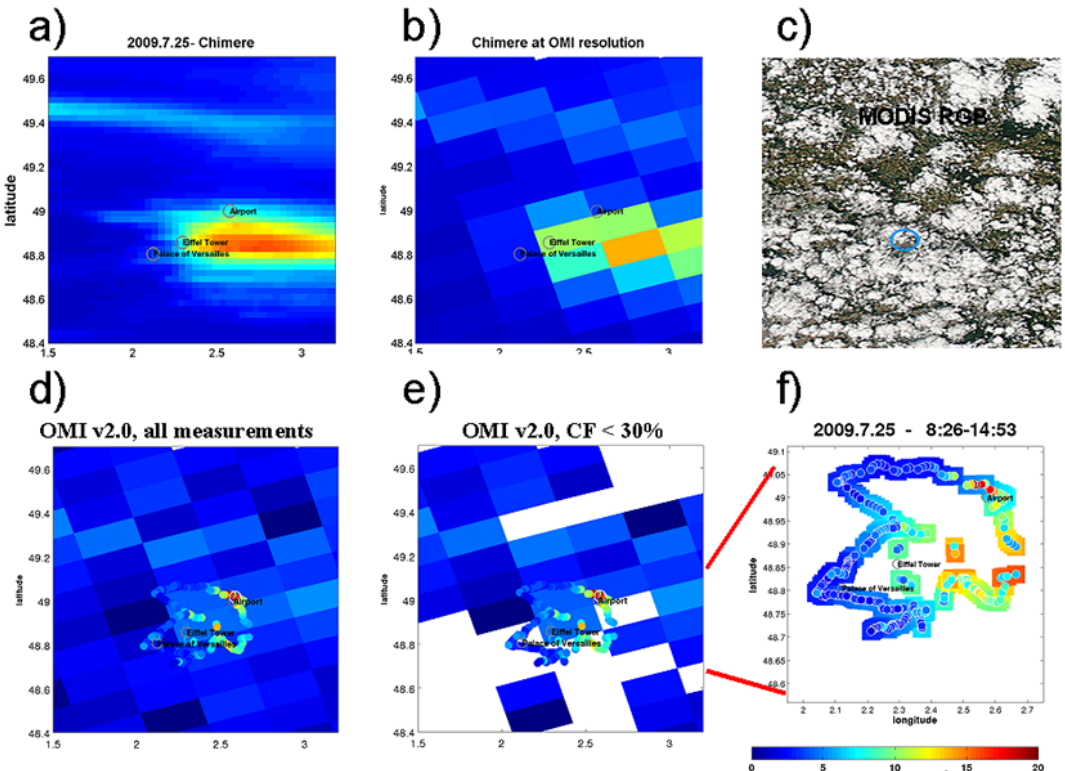
Figure 4. Same as Fig. 3 for the 25 July 2009. OMI overpass was on 12:47; the car-MAX-DOAS measurements were performed between 8:26 and 14:53; the measurements around the large circle were performed between 11:37 and 14:07.